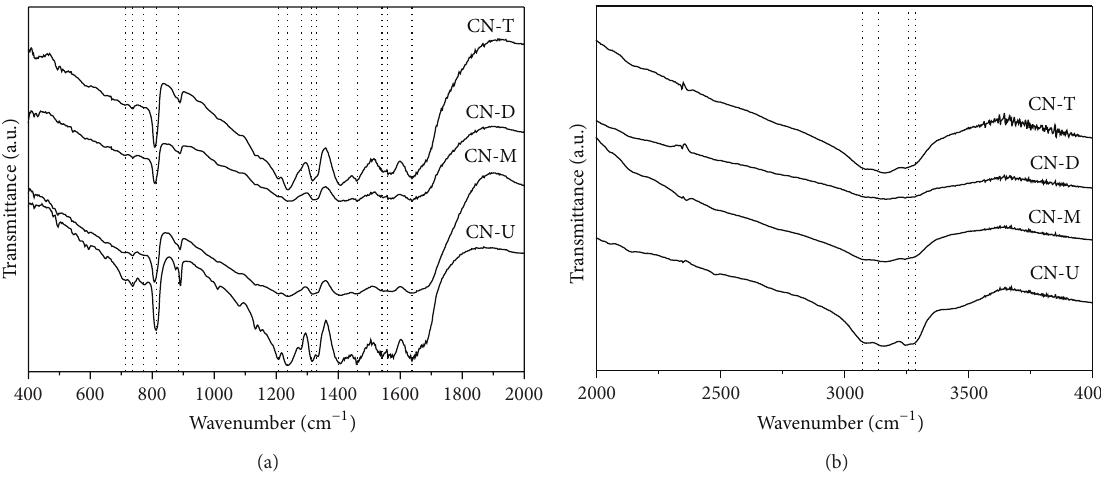
Figure 2: FT-IR spectra for CN-T, CN-D, CN-M, and